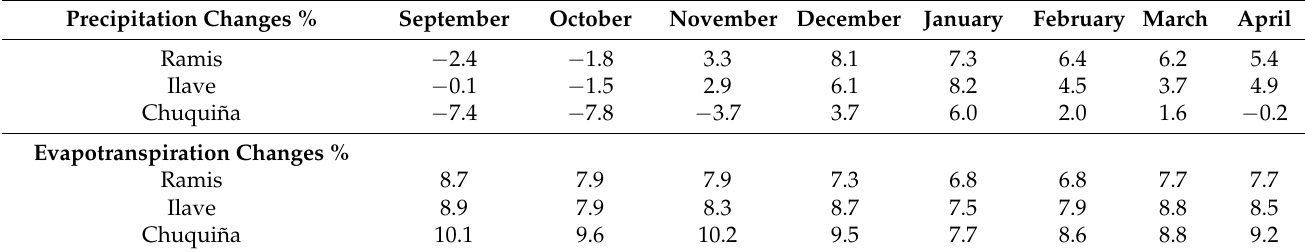
Table 3. Precipitation and evapotranspiration (ET) changes (%) during the wet season (September–April) for the 2034–2064 period relative to 1984–2014 for the basins controlled at the Ramis, Ilave (Peru), and Chuquiña (Bolivia) stations. Precipitation Changes %